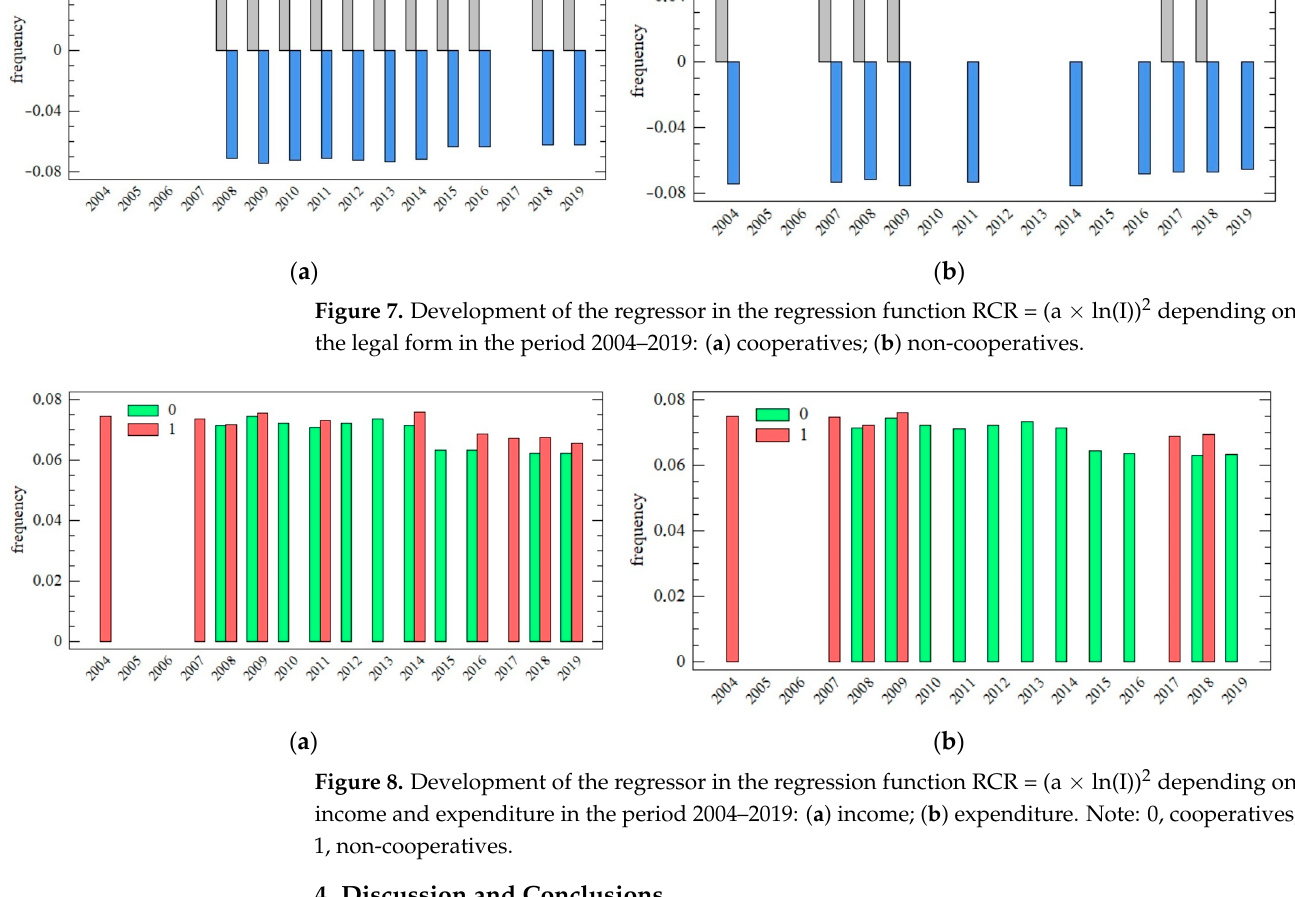
Figure 7. Development of the regressor in the regression function RCR = (a × ln(I)) 2 depending on the legal form in the period 2004–2019: ( a ) cooperatives; ( b ) non-cooperatives.